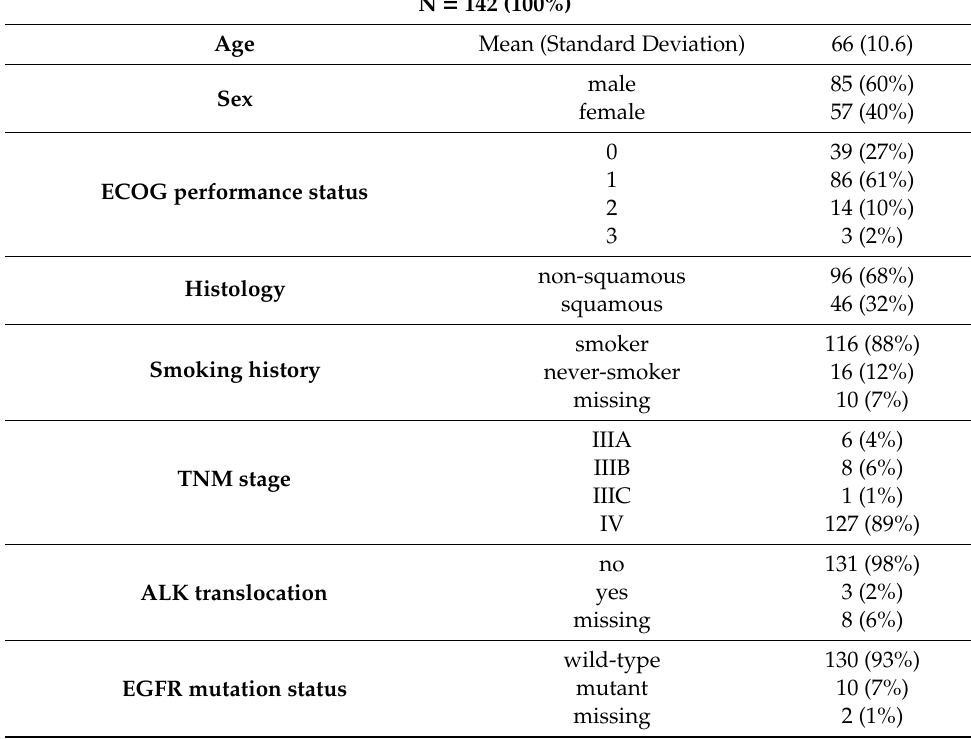
Table 1. Baseline characteristics of 142 advanced NSCLC